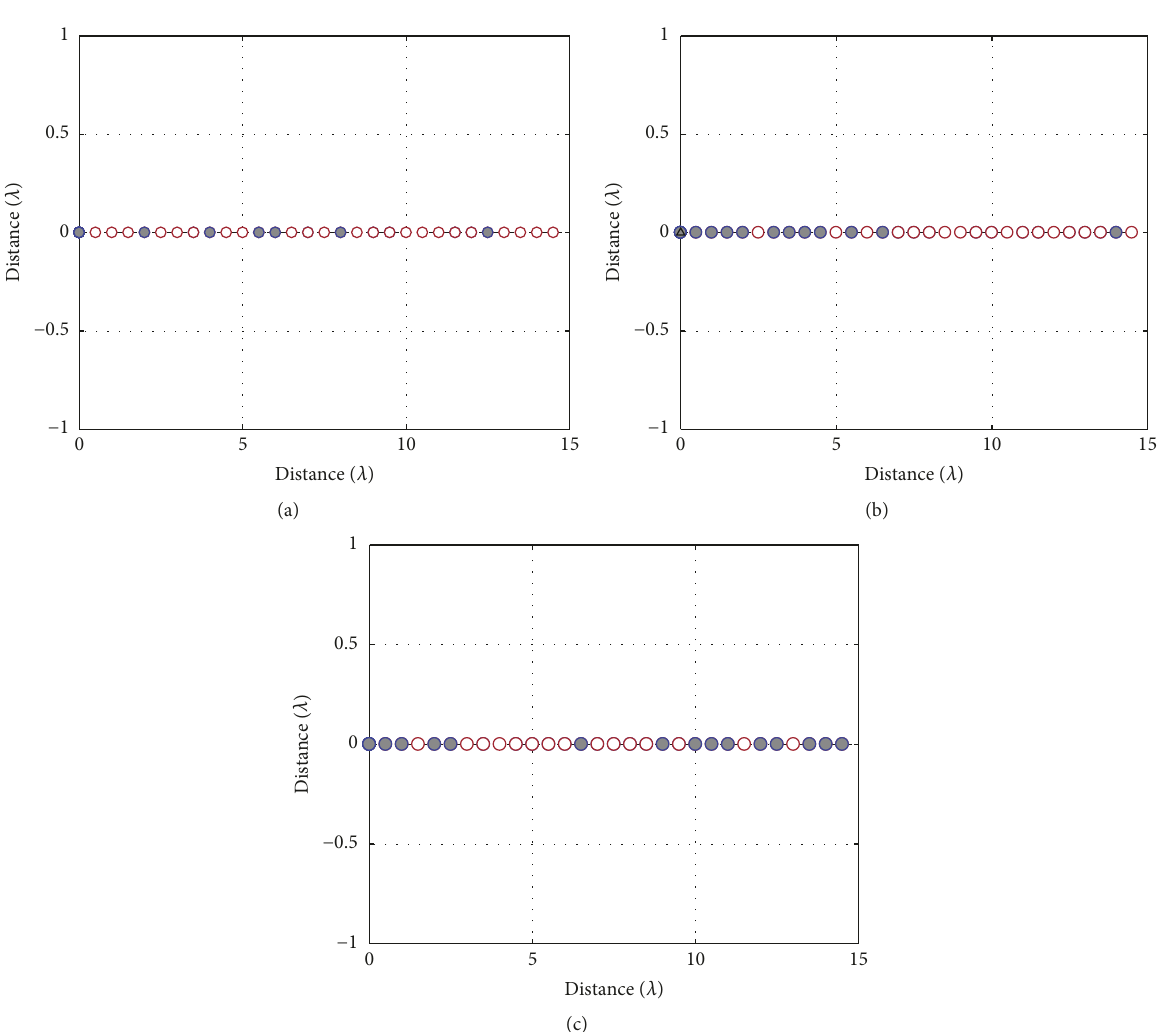
Figure 7: The sparsity of GNSS array obtained from employing the CSMC beamformer with different norm constraints: (a) 𝑡 = 25 % ×‖ w 𝑜𝑝𝑡 ‖ 1 ; (b) 𝑡 = 45 % × ‖ w 𝑜𝑝𝑡 ‖ 1 ; (c) 𝑡 = 65 % × ‖ w 𝑜𝑝𝑡 ‖ 1